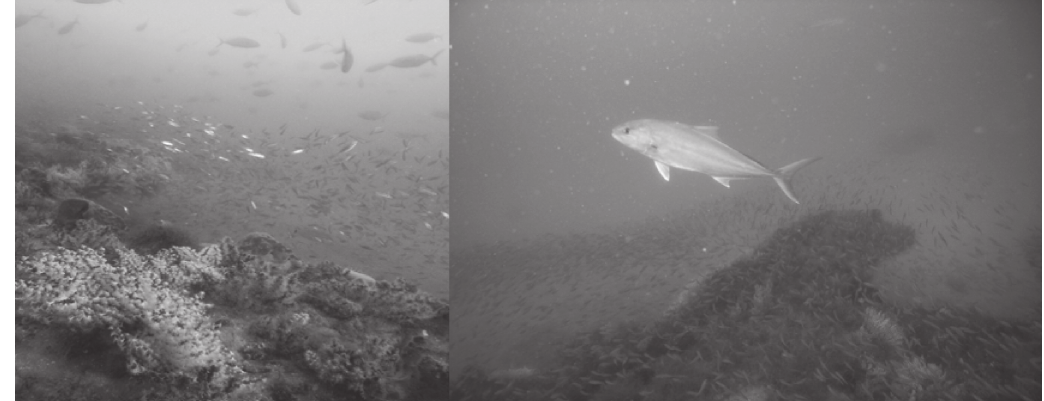
Fig. 1. A school of blue runner Caranx crysos (top left) and group of greater amberjack Seriola dumerili (right, one visible in photograph) drive prey fishes down to ledge habitat during predation